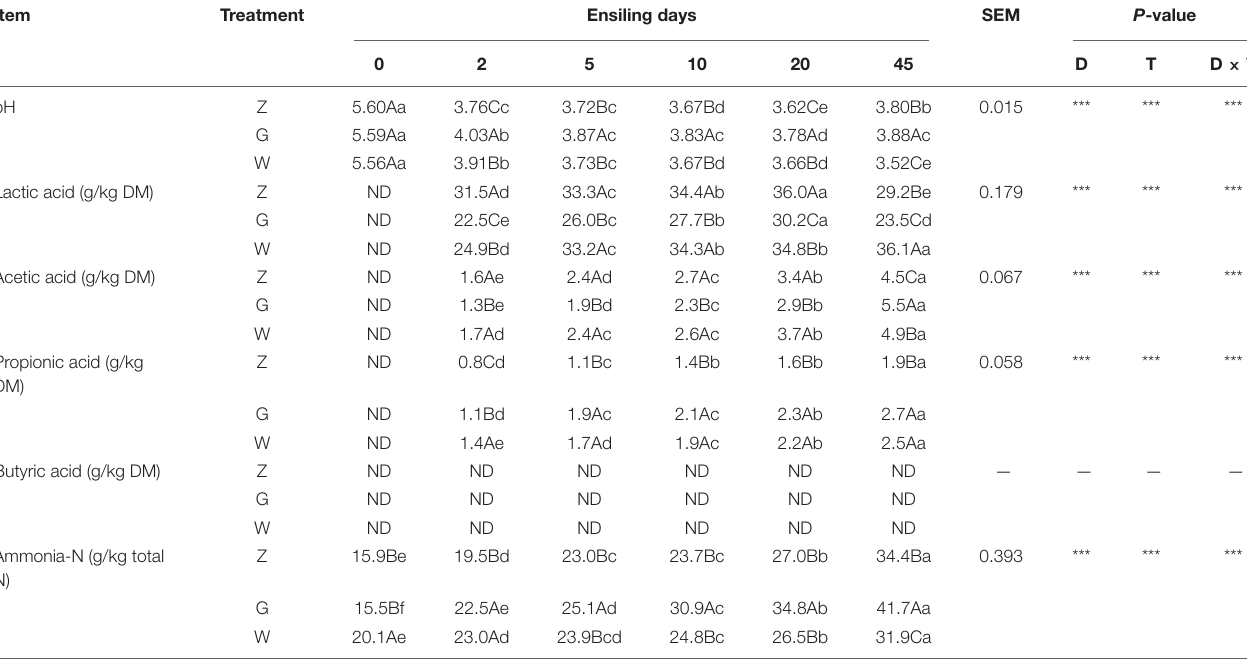
TABLE 2 | Fermentation quality of whole-plant maize silage in different regions. Item Treatment Ensiling